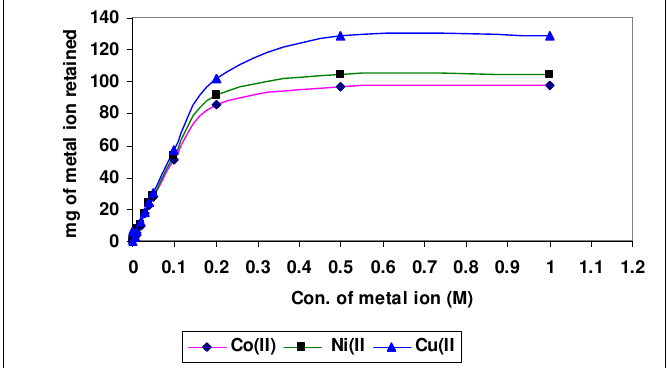
Figure 3 . Preconcentration of Co(II), Ni(II) and Cu(II) as a function of concentration (5.0 g of ligand system, flow rate 1.0 -1.5 cm 3 min -1 , pH = 5.5).